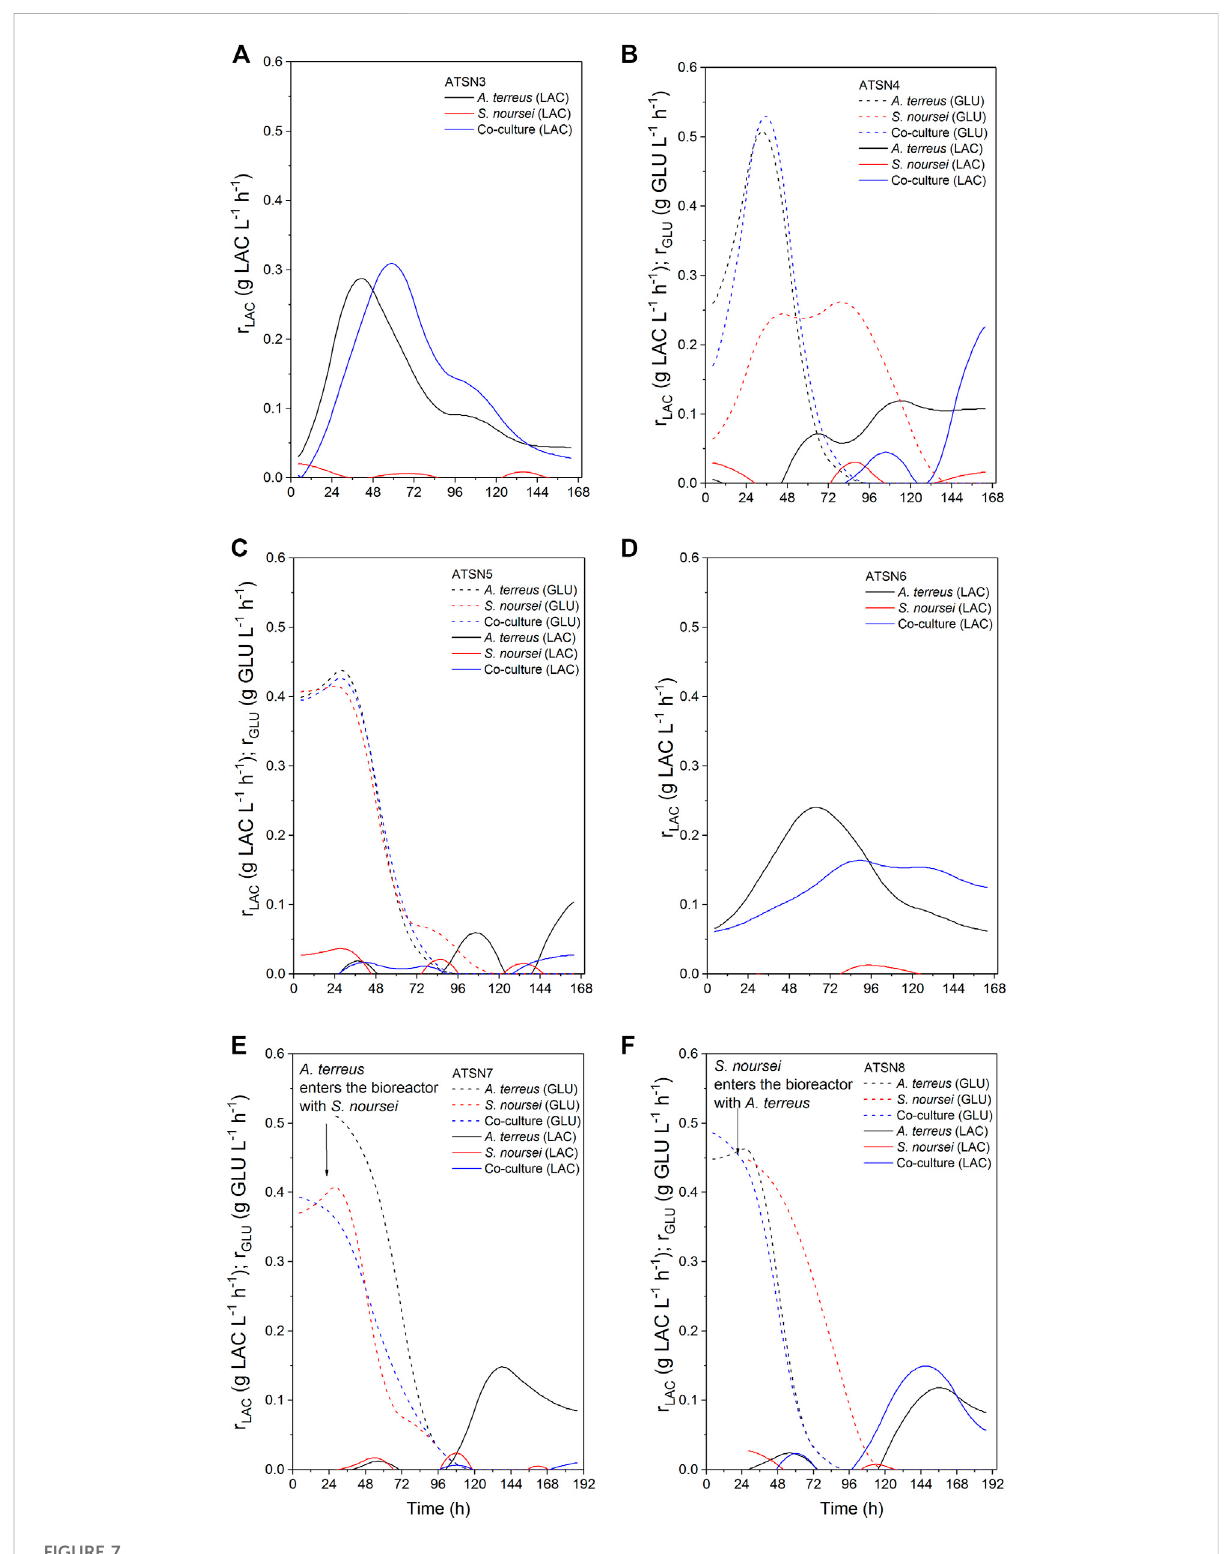
FIGURE 7 Kinetics of carbon substrates (glucose and lactose) uptake in A. terreus and S. noursei co-cultures and the corresponding monocultures in the (A) ATSN3, (B) ATSN4, (C) ATSN5, (D) ATSN6, (E) ATSN7, and (F) ATSN8